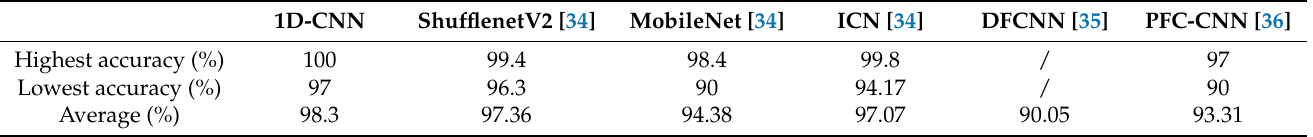
Table 5. Accuracy contrast between different loads on different